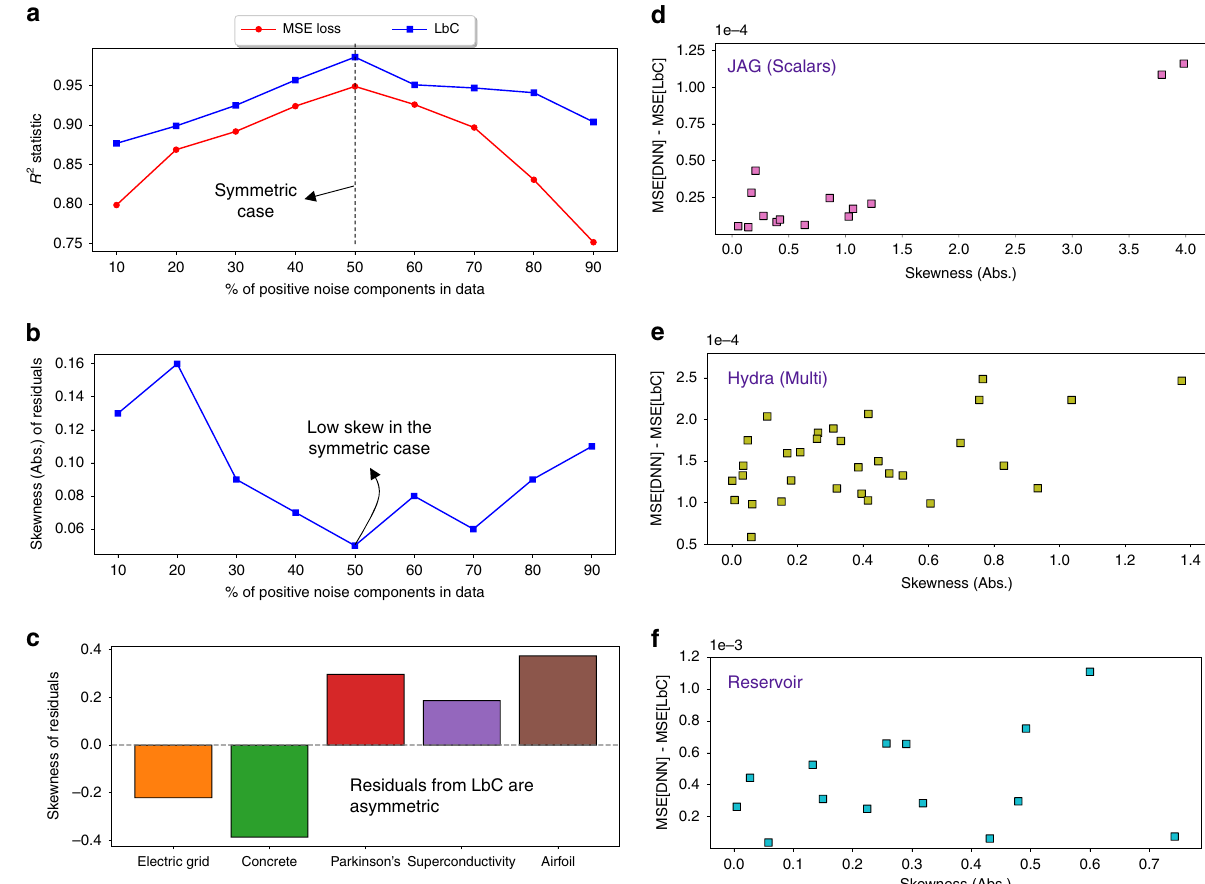
Fig. 4 In-depth analysis of Learn-by-Calibrating (LbC). Using the synthetic function in Fig. 1, we fi nd that a LbC produces signi fi cantly improved generalization at varying levels of asymmetry in the inherent noise structure and b the skewness of the residuals from LbC re fl ects that. For all the test cases considered in our study, c we fi nd that the residuals are highly asymmetric and heavy-tailed. Interestingly, from fi gures d – f , we observe that, in cases where the performance gains are signi fi cant (difference between MSEs of deep neural networks (DNN) and LbC), the corresponding skewness of the residual distribution is high. This clearly evidences the ability of our approach to reveal the inherent noise structure in the